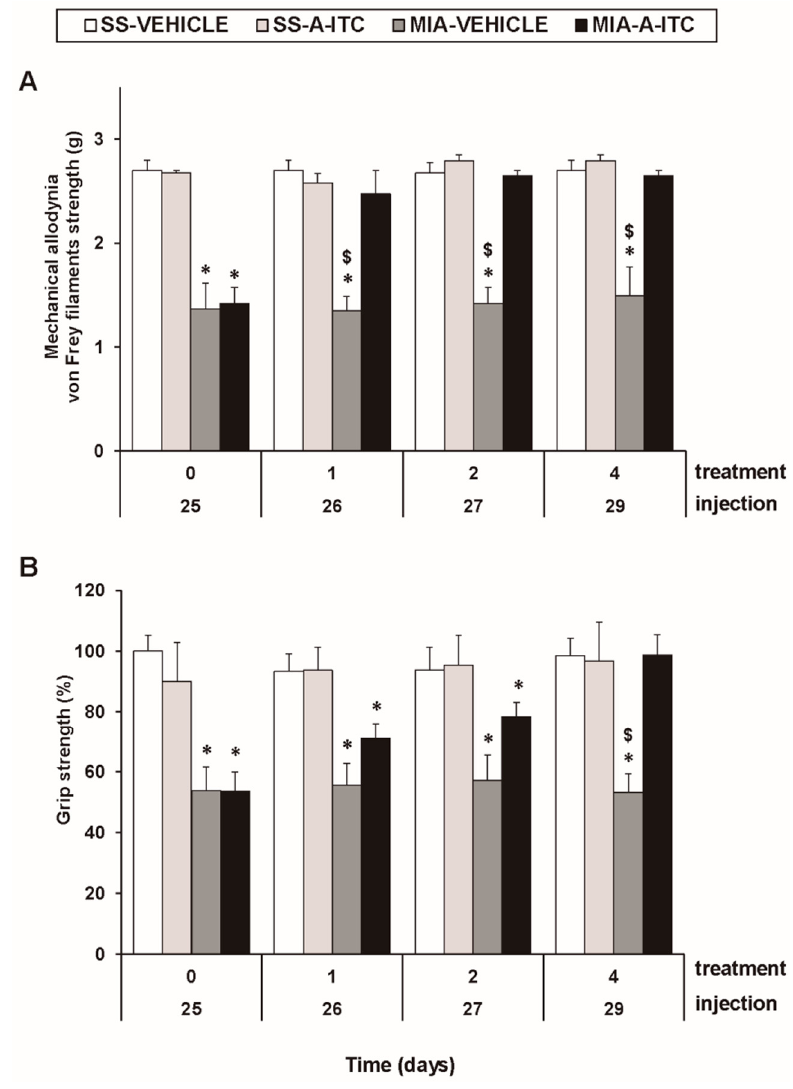
Figure 1. Treatment with allyl isothiocyanate (A-ITC) reduces the mechanical allodynia and the grip strength deficits induced by the intra-articular injection of MIA. The development of ( A ) mechanical allodynia in the ipsilateral paw and ( B ) grip strength deficits in the hind paws of the MIA- or SS-injected mice treated with A-ITC or vehicle for 4 consecutive days are shown. The effects of A-ITC were evaluated at days 26, 27, and 29 after MIA or SS injection. For each test and time evaluated, * denotes significant differences vs. their respective SS-injected mice, and $ denotes significant differences vs. MIA-injected mice treated with A-ITC ( p < 0.05; one-way ANOVA followed by the Student–Newman–Keuls test). The results are shown as the mean values ± SEM; n = 6 animals per Table 1. Summary of the one-way ANOVA’s performed with the results obtained for the mechanical experimental group. allodynia and grip strength deficits at 0, 1, 2, and 4 days after the administration of allyl isothiocyanate (A-ITC) or vehicle in saline (SS) and monosodium iodoacetate (MIA)-injected mice. Time of Treatment (days) 0 1 Mechanical F 3,20 = 25.15 F 3,20 = 18.27 F 3,20 = 17.98 allodynia p < 0.001 p < 0.001 p < 0.001 Grip strength p <